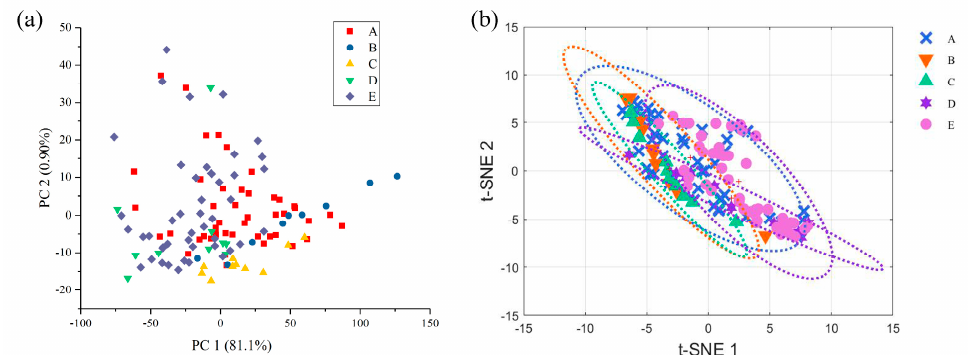
Figure 2. PCA ( a ) and t-SNE ( b ) feature visualization of Lingzhi Figure 2 . PCA ( a ) and t-SNE ( b ) feature visualization of Lingzhi samples. Figure 2 . PCA ( a ) and t-SNE ( b ) feature visualization of Lingzhi samples.